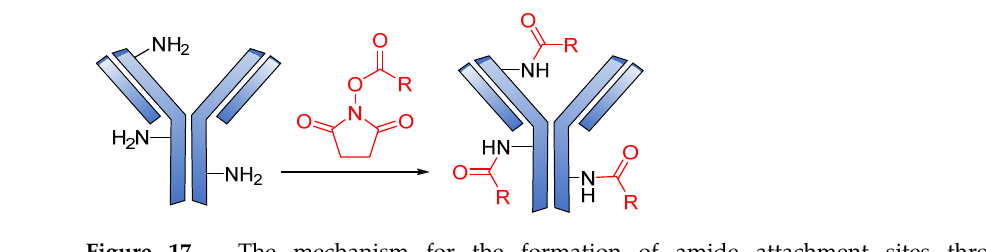
Figure 19. Side-reactions undergone by the succinimide–thioether moiety.